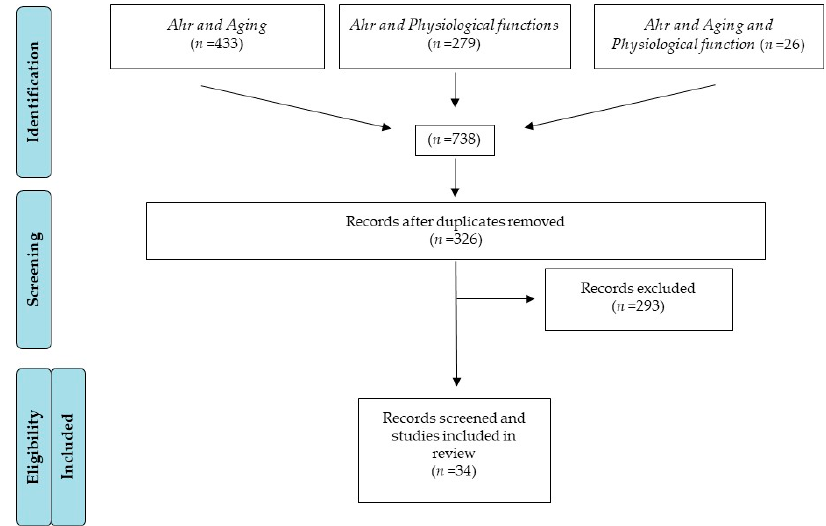
Figure 5. PRISMA flow diagram of literature review process for this study. Supplementary Materials: The following are available online at https://www.mdpi.com/1422-0067/22/1/374/s1. METHODS. Study population. Peripheral blood mononuclear cells isolation. Isolation of total RNA from peripheral blood mononuclear cells. Gene expression profiling. Microarray data